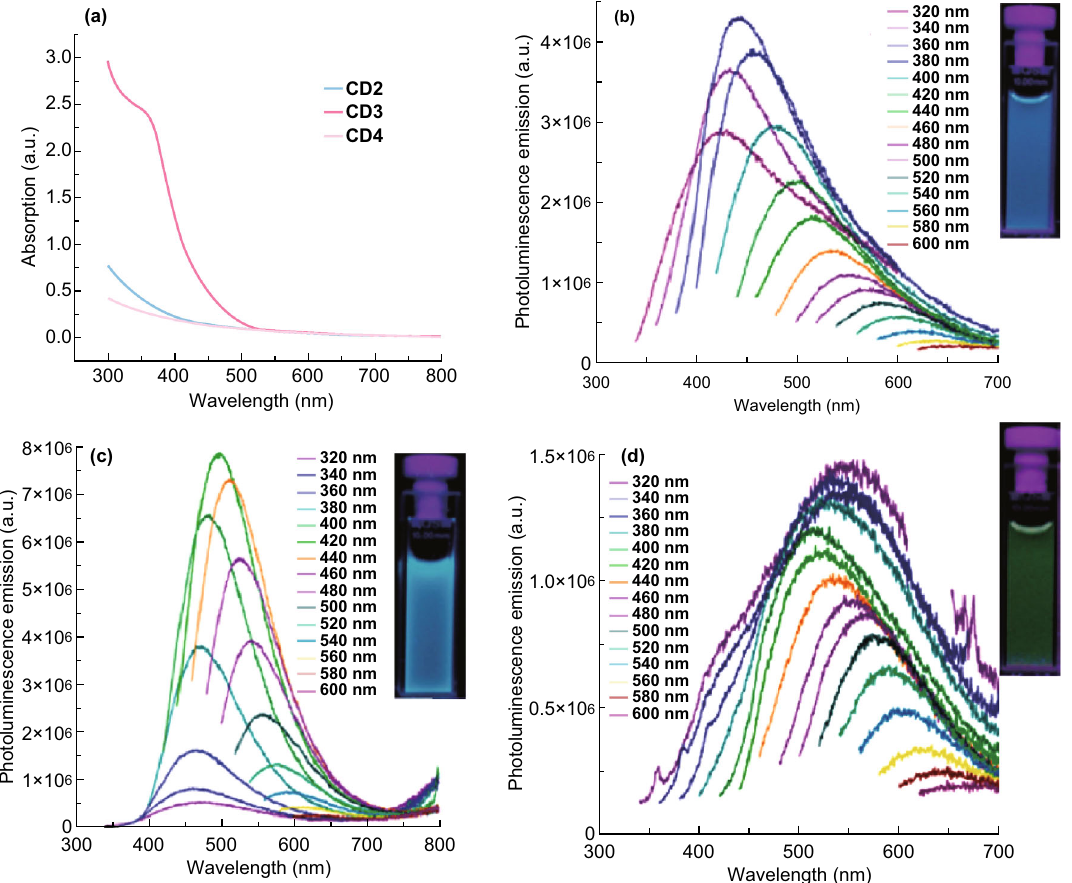
Fig. 11 a Absorption spectra of CD2, CD3, and CD4; and PL spectra of b CD2, c CD3, and d CD4. The inset image corresponds to CDs under 365 nm UV light illumination [94]. Copyright (cid:2) 2010 American Chemical Society